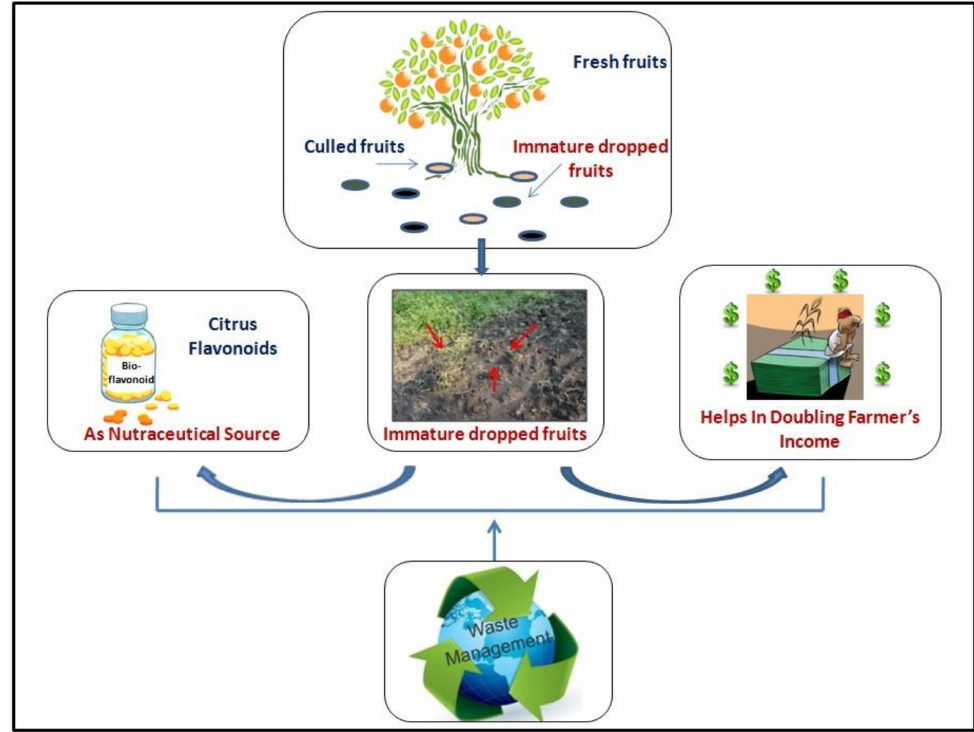
Figure 1. Pictorial abstract of the